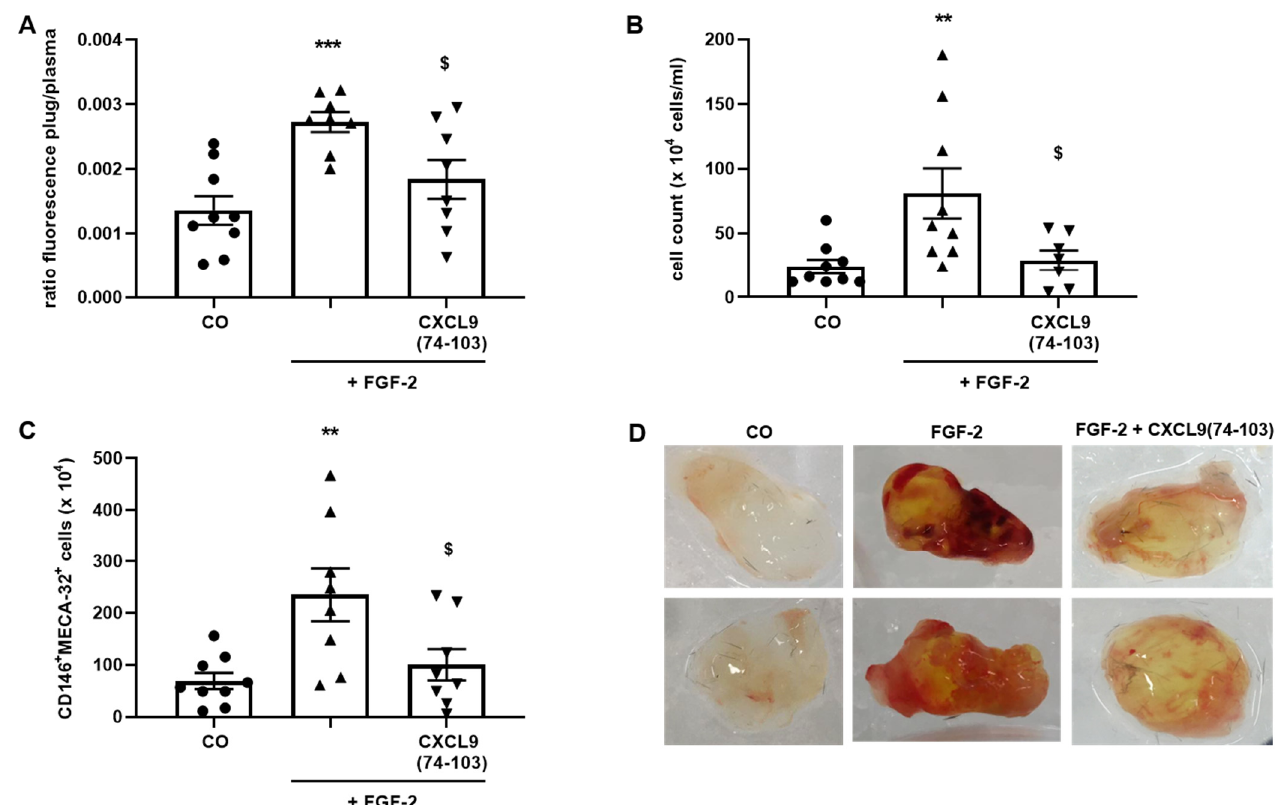
Figure 10. CXCL9(74-103) reduces FGF-2-induced neovascularization. Matrigel loaded with 180 ng FGF-2 with or without 300 µ g CXCL9(74-103) was s.c. injected in mice. Dorsal s.c. implanted pumps allowed the gradual release of CXCL9(74-103) (400 µ g over 7 days) or PBS. Seven days later, the mice were i.v. injected with high molecular weight FITC-dextran 30 min before sacrifice. The plugs were digested and ( A ) the ratio of fluorescence in the plug compared to plasma was determined, ( B ) the number of cells inside the plugs was counted and ( C ) the endothelial cell population was analyzed with flow cytometry. ( D ) Representative images of control, FGF-2 and FGF-2 + CXCL9(74-103) plugs are depicted. [mean (±SEM); Mann–Whitney U test; ** p < 0.01, *** p < 0.001 (compared to control plugs); $ p < 0.05 (compared to FGF-2-containing plugs); (CO group: n = 9, FGF-2 group: n = 8–9, FGF-2 + CXCL9(74-103) group: n = 7–8); the experiment was repeated three times].